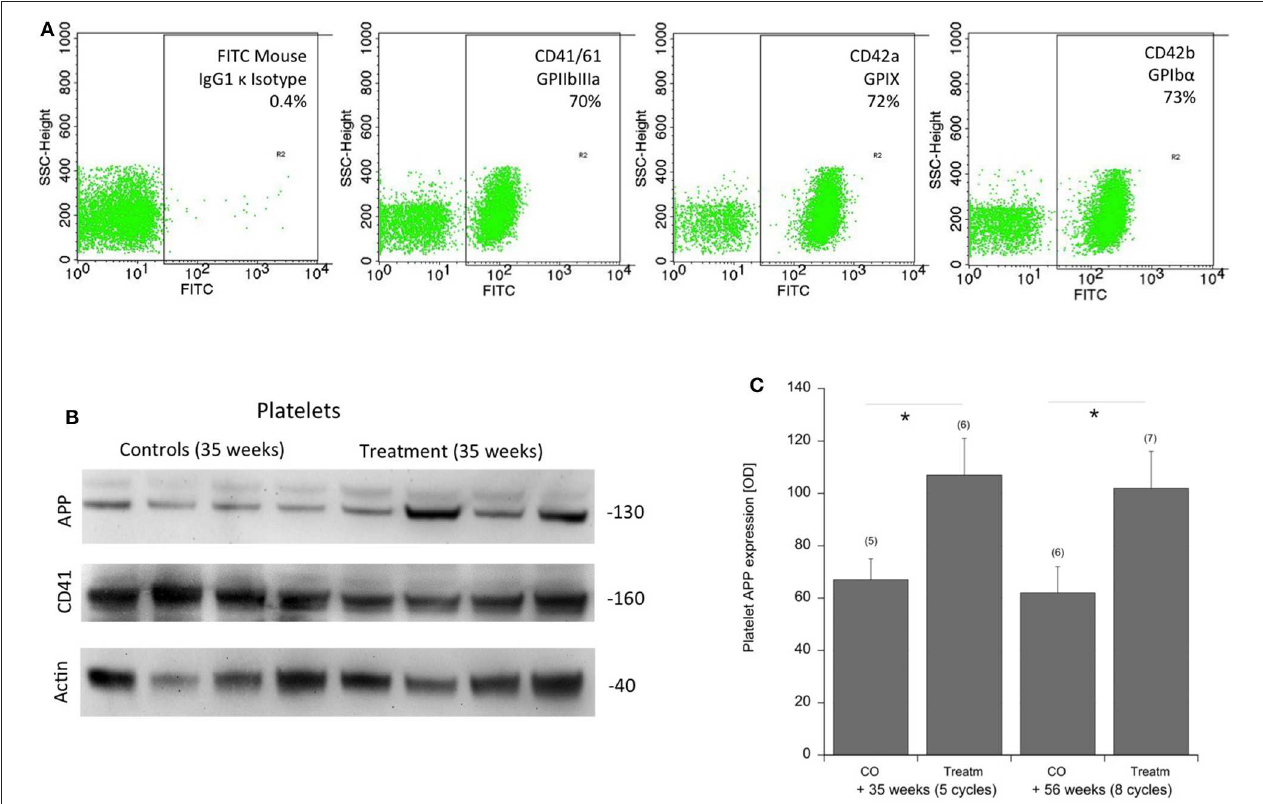
FIGURE 2 | Characterization of platelets by FACS and APP expression in the mouse CAA model. (A) Platelets were characterized by FACS analysis for CD41/61 GPIIbIIIa, CD42a GPIX, CD42b GPIb α compared to an IgG control. (B) Amyloid precursor protein (APP) was measured by Western blots and showed a 130-kDa protein. Actin and CD41 served as controls. Size markers are given as kDa. (C) Statistical analysis was performed by ANOVA with a subsequent Fisher LSD post-hoc test (* p < 0.05). Note an increased expression of APP in platelets of sporadic CAA mice in both treatment groups at 35 and 56 weeks of age (Treatm) compared to age-matched controls (CO). Values are given as mean ± SEM optical density. Numbers in parenthesis show numbers of